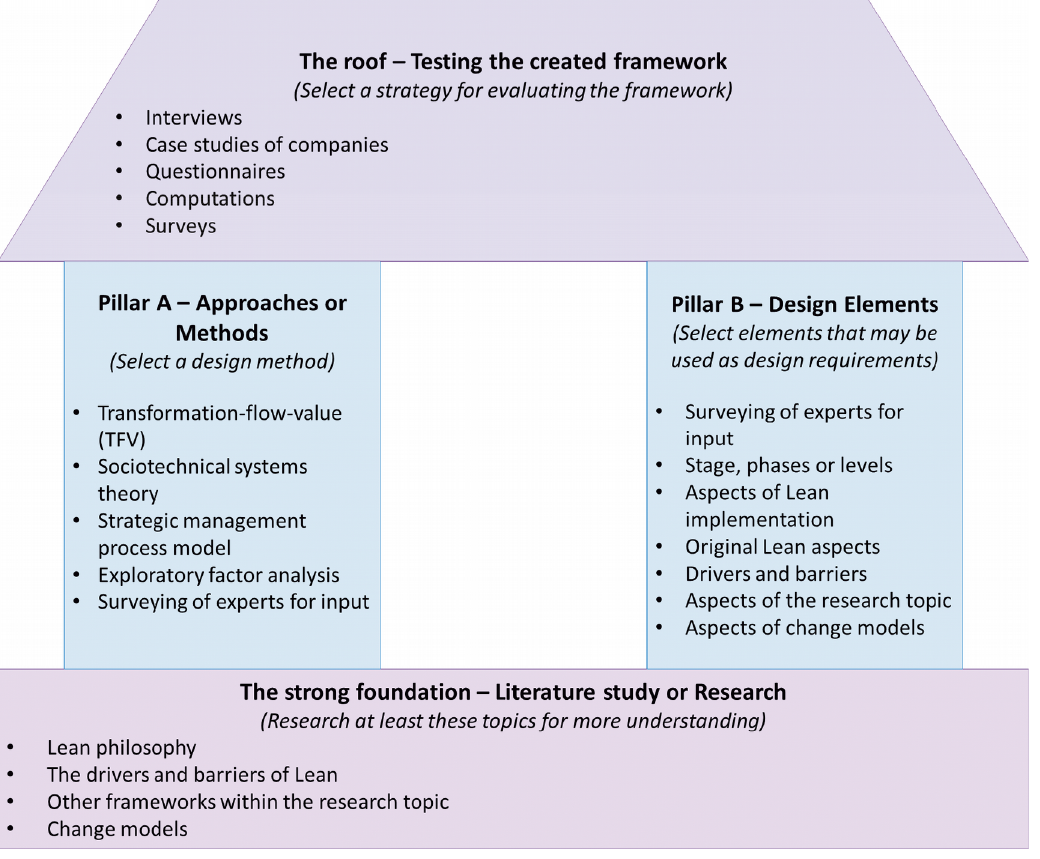
Figure 4. House of guidance for designing a Lean